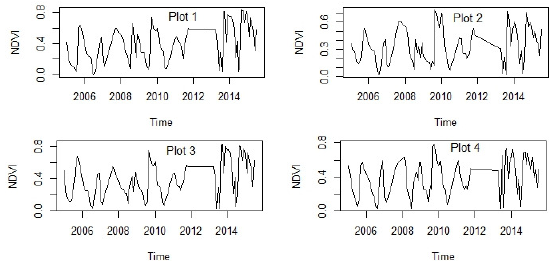
Figure 4. Raw NDVI time series observed over selected Citrus orchards